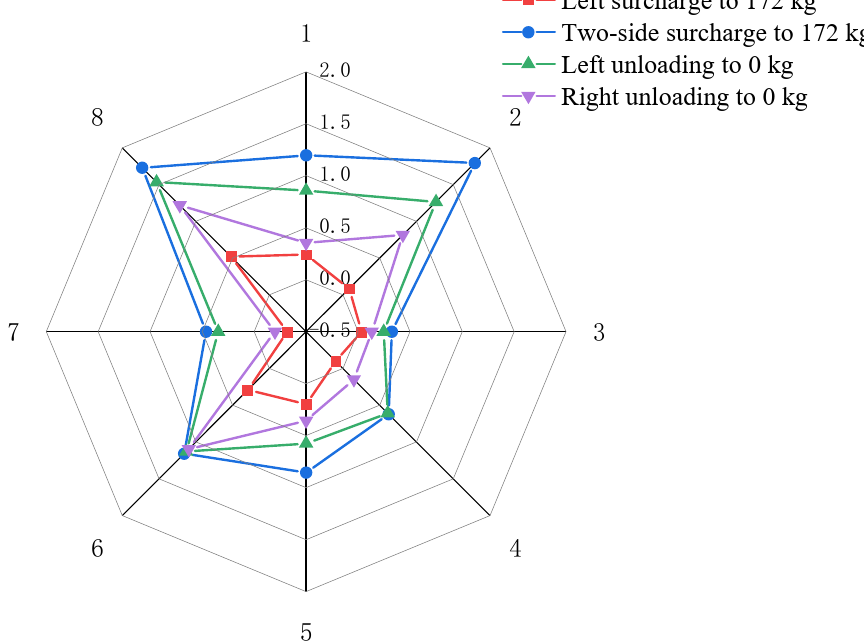
Figure 15. Variation in additional surrounding pressure under different surcharges for Case 3 (unit: kPa).